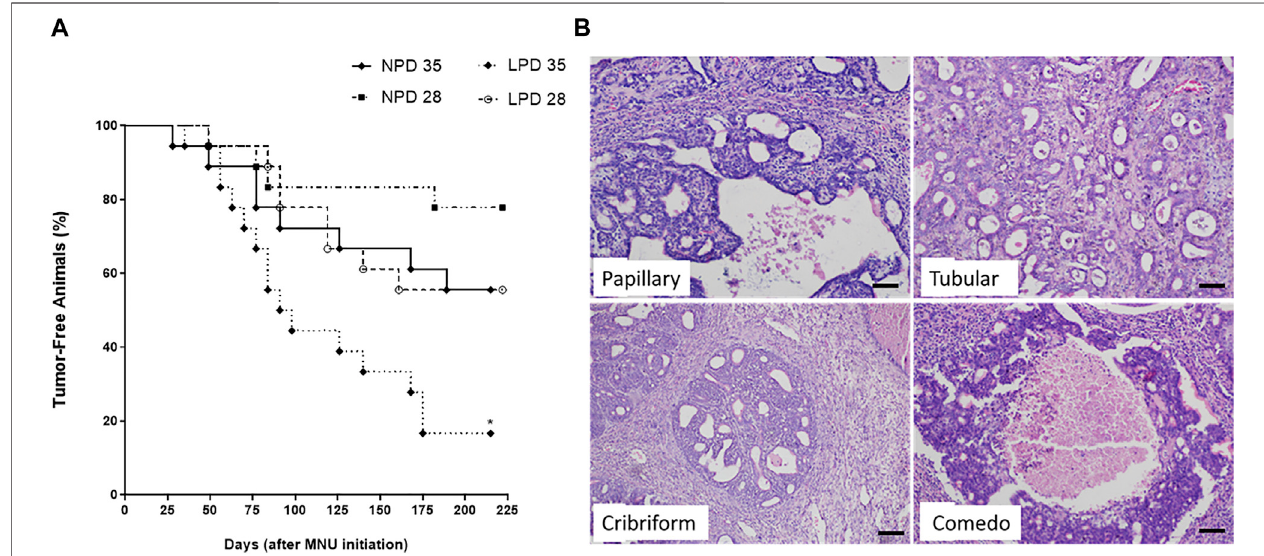
FIGURE 4 | Percentage of tumor-free animals (A) . Time represents the MNU-postinitiation days. NPD, normoprotein diet; LPD, low-protein diet. Postnatal day of MNU administration (28 or 35). MNU, N -methyl- N -nitrosourea administration (25 mg/kg, i.p.; single dose). *Statistically different from NPD 35 ( p (cid:1) 0.020). (B) Photomicrographs from tumors histological sections stained by hematoxylin – eosin (scale bar (cid:1) 20 µm).